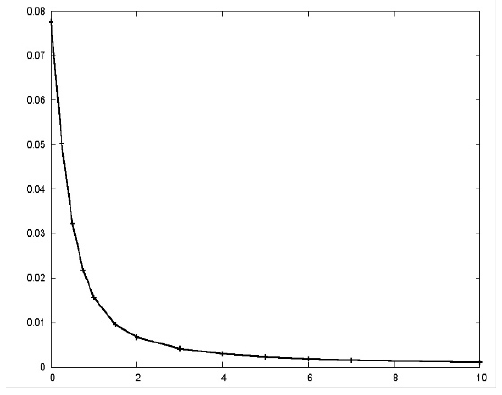
Figure 5. The decay of D